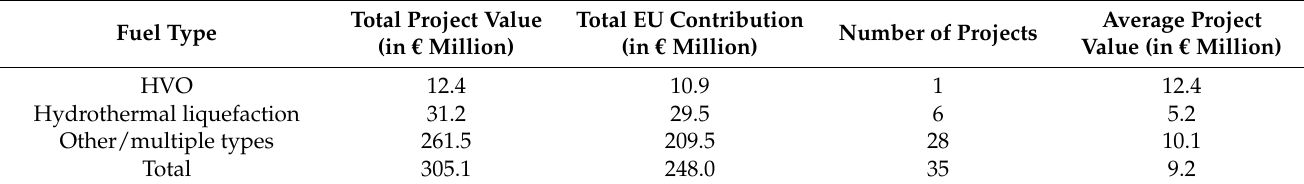
Table 5. Projects and levels of funding identified for synthetic paraffinic